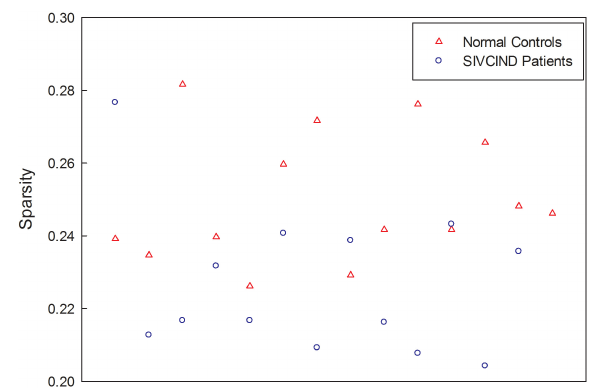
constant and ranged from 14 to 20% ( Supplementary Figure S1 ); to 14%, was employed in this